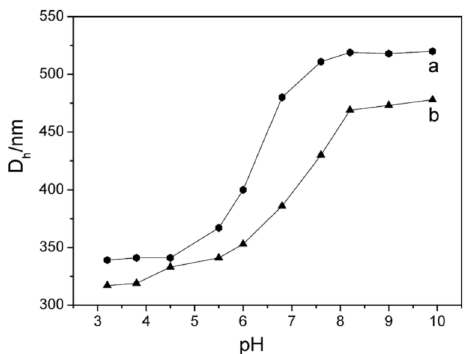
Figure 16. Hydrodynamic diameter (Dh) of PMAA hollow microspheres as a function of pH in the (a) absence and (b) presence of added NaCl to maintain a constant ionic strength at 0.01 M. Reproduced from [111] with permission from the American Chemical